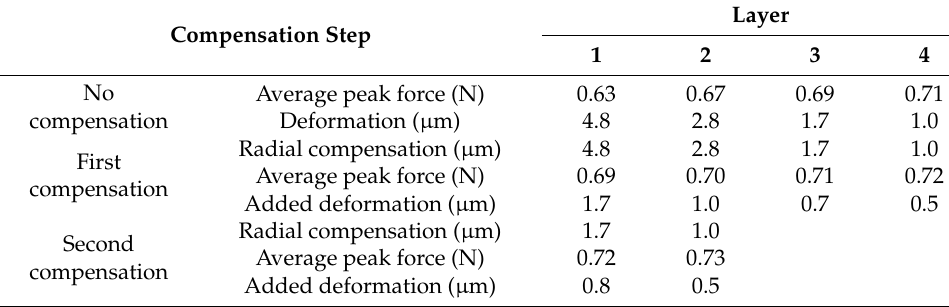
Table 6. The simulation results for the thin wall of 120 µ m